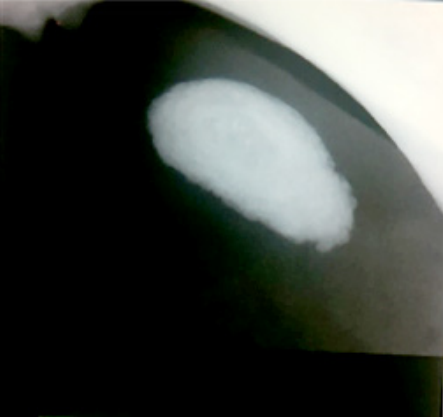
Fig 2 : Occlusal X-ray showing radio-opacity in left floor of mouth